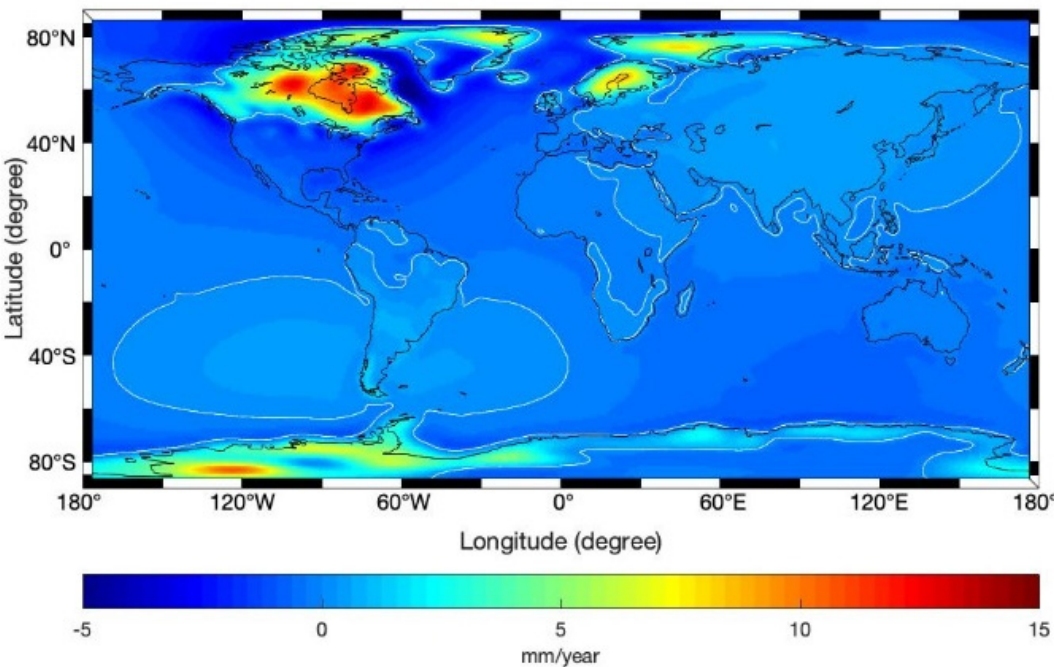
Figure 10. Final results for GIA uplift rates: The ICE6Gavg (GPS) solution. The zero-motion contours are indicated by white curves.